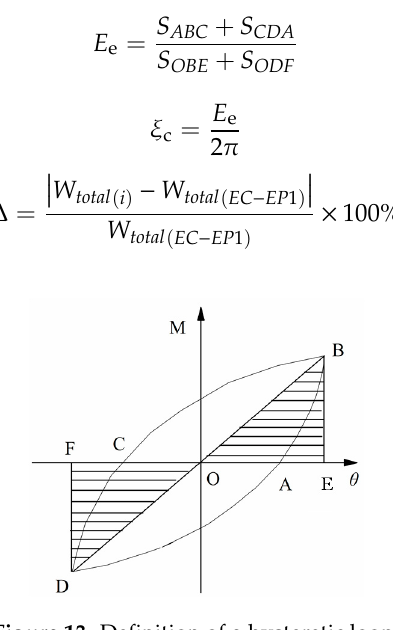
Table 6. Key parameters of energy dissipation.